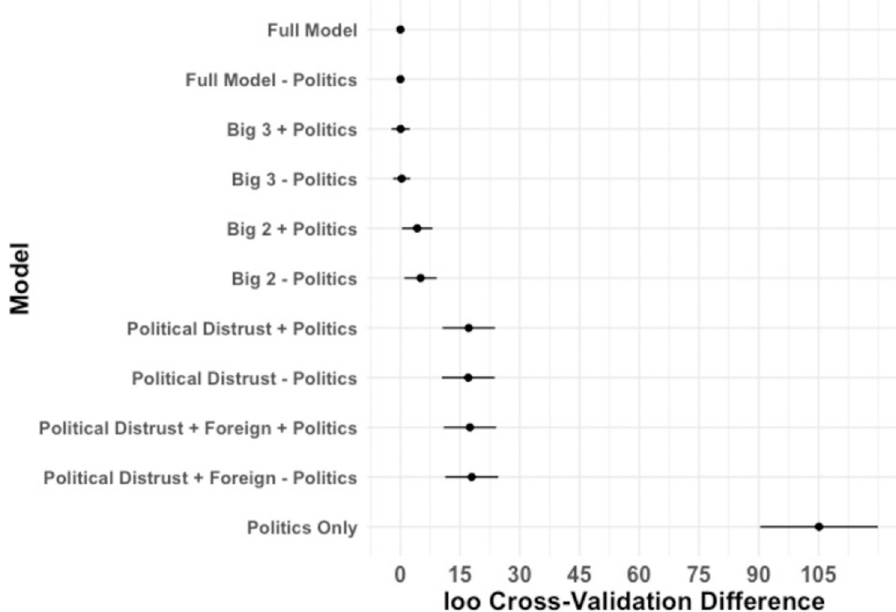
Fig 5. Model comparisons predicting COVID-19 attitudes for the prewave survey using leave-one-out (loo) cross- validation information criteria. Error bars indicate SE of estimate. The simplest model within the SE of the full model, “Big 2 –politics”, includes the two strongest predictors of skepticism (distrusting Democratic politicians and COVID-19 vaccine fears), and does not include participants’ political attitudes.